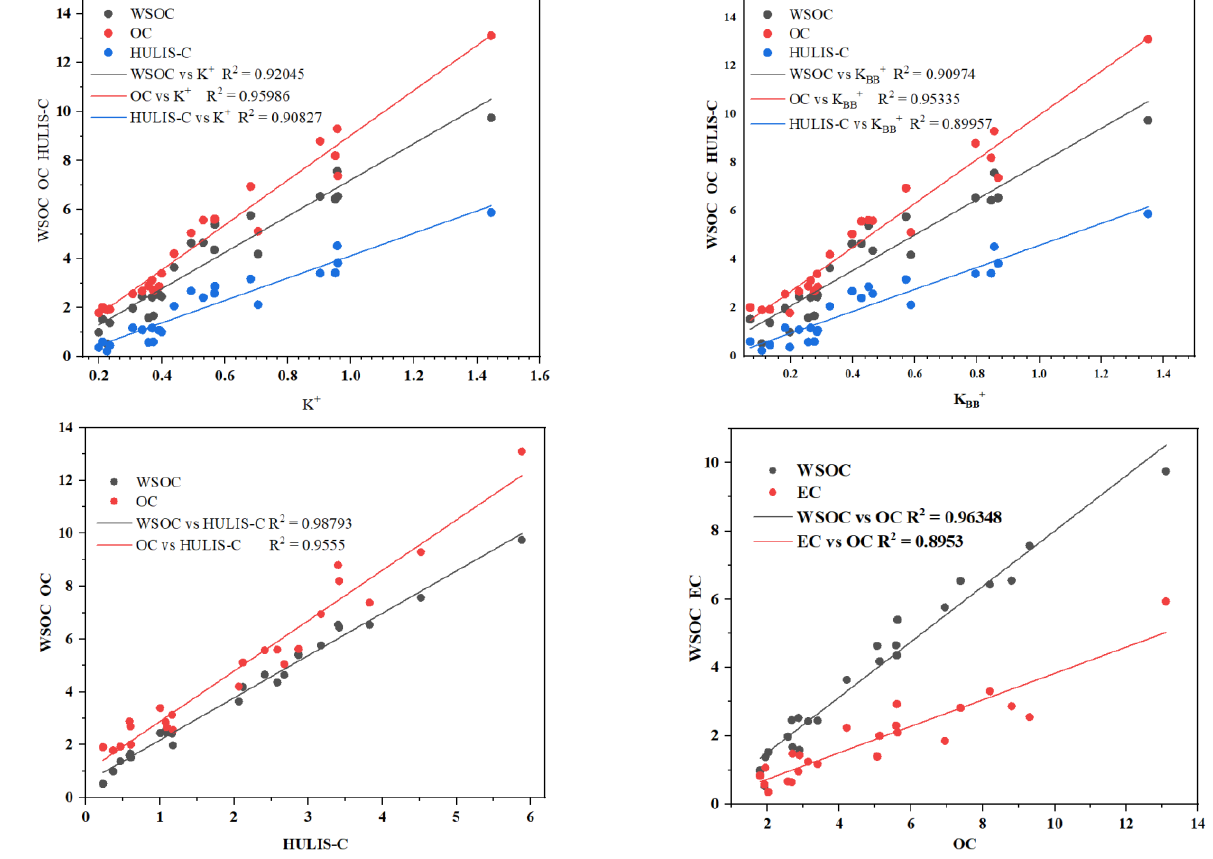
Figure 3. Relationships between OC and EC and WSOC concentrations during winter.